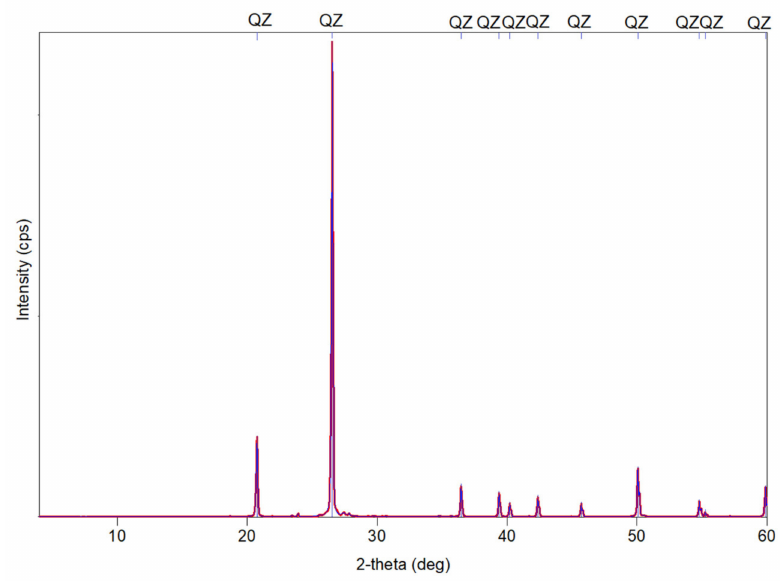
Figure 3. X-ray diffraction patterns of the standard sand used in this